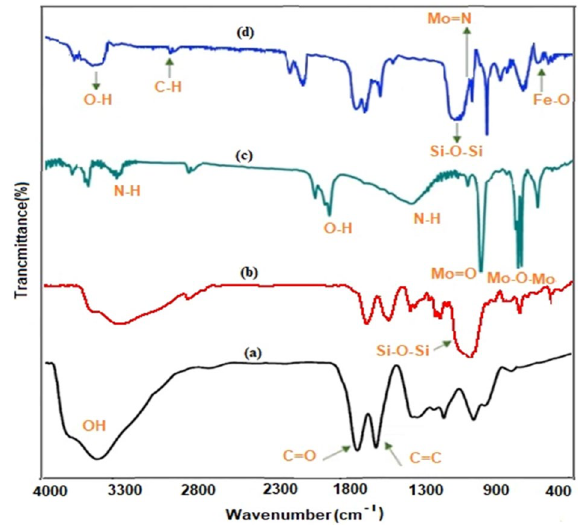
Figure 2. FT-IR spectra of ( a ) GO, ( b ) Fe 3 O 4 /GO-NH 2 , ( c ) POM, and ( d ) Fe 3 O 4 /GO/[FeMo 6 ].